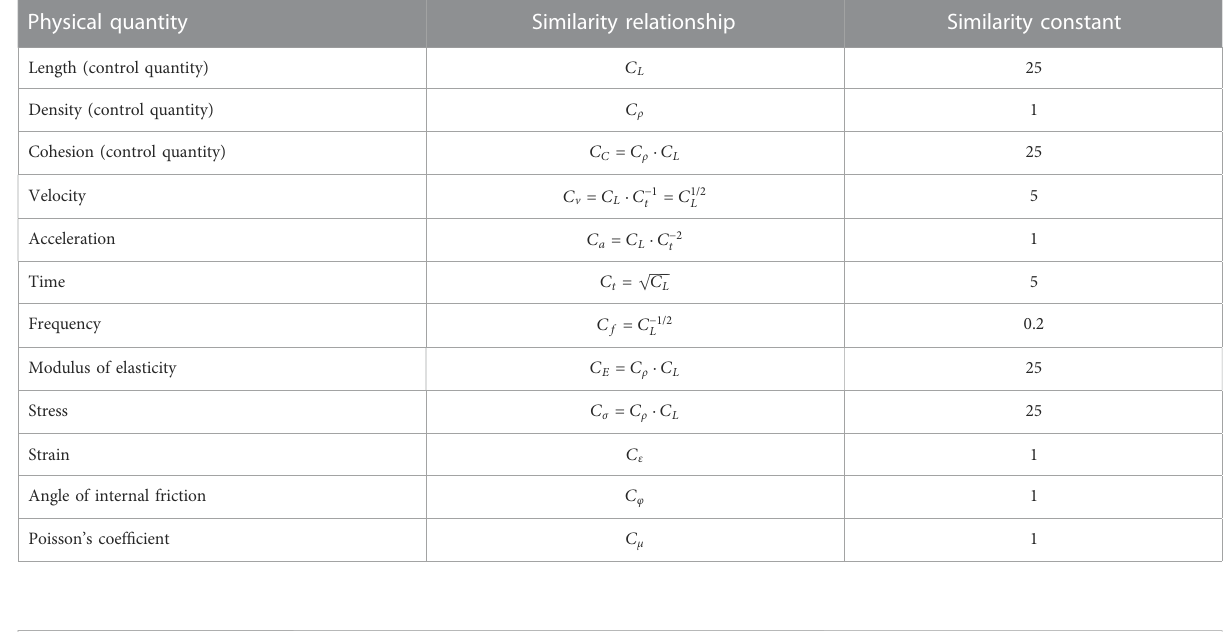
TABLE 1 Similarity constants for the shaking model test.